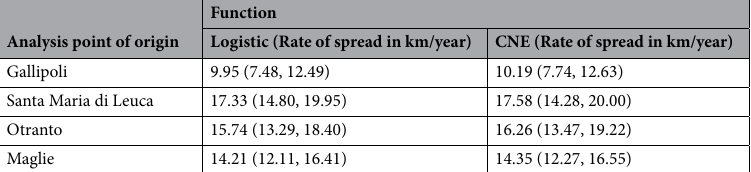
Table 5. Rate of spread estimates of the logistic and constrained negative exponential functions when assuming different points of origin in the analysis of the Puglia data (see Supplementary Analysis 2). The values between the brackets are the lower and upper 95% confidence limits in km/year. CNE constrained negative exponential.